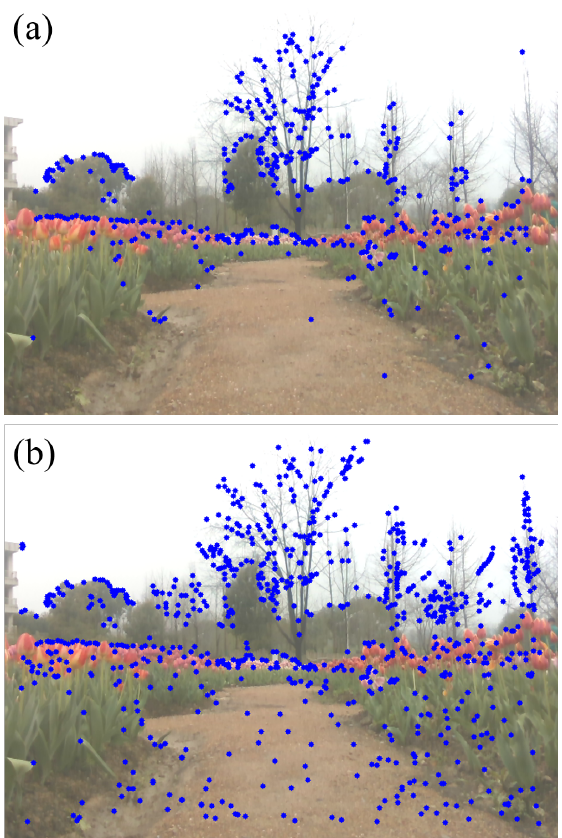
Figure 4. Feature point extraction results under different methods: ( a ) Fixed threshold; ( b ) adaptive threshold T a